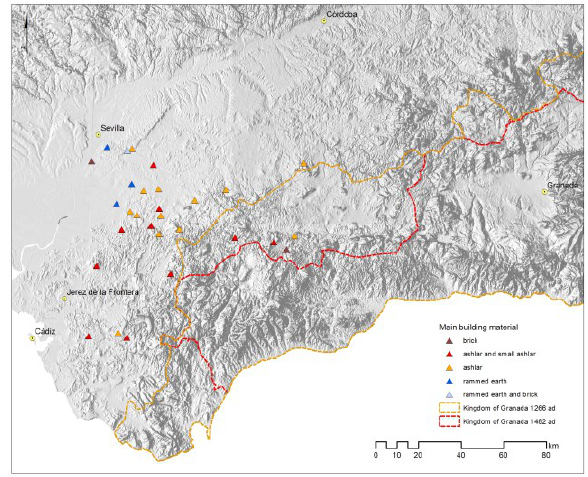
Figure 3: Thematic map of the main building material of the towers.